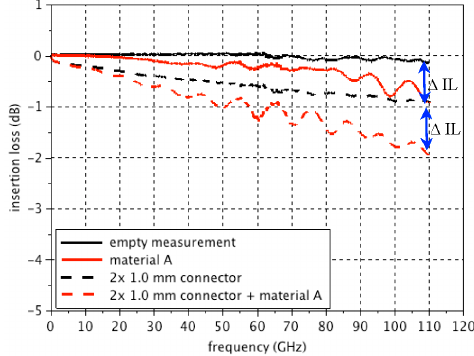
Figure 7. Insertion loss of an ACP measured with different reference planes (Reproduced with permission from [6], IEEE, 2017).